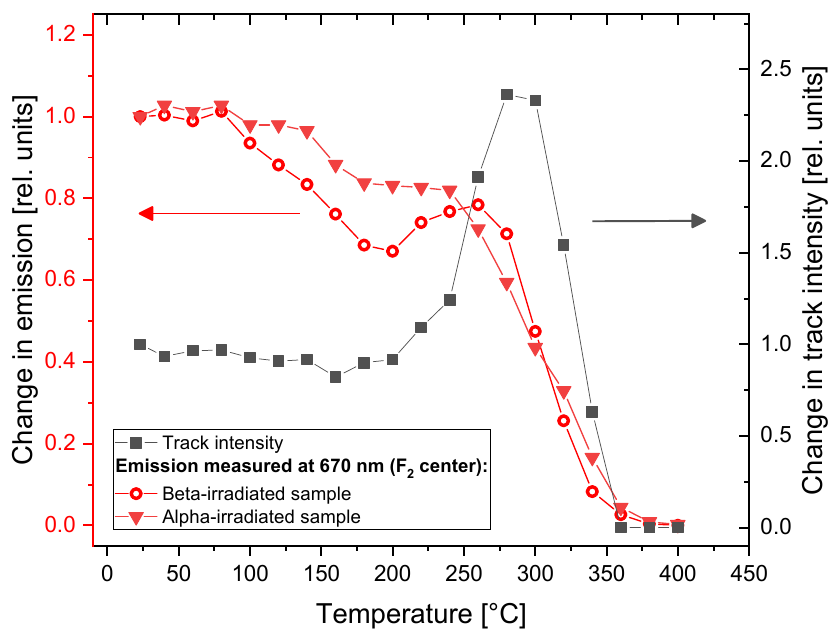
Figure 11. Relative changes in PL intensity for the beta-irradiated sample (30 kGy) and the sample irradiated with alpha particles, fluence 3.4 × 10 12 cm − 2 (left axis), in comparison to changes in fluorescent tracks intensity observed for the sample irradiated with a low fluence (1.6 × 10 6 cm − 2 ) of alpha particles (right axis). Arrows and plot colors indicate the applicable axes.